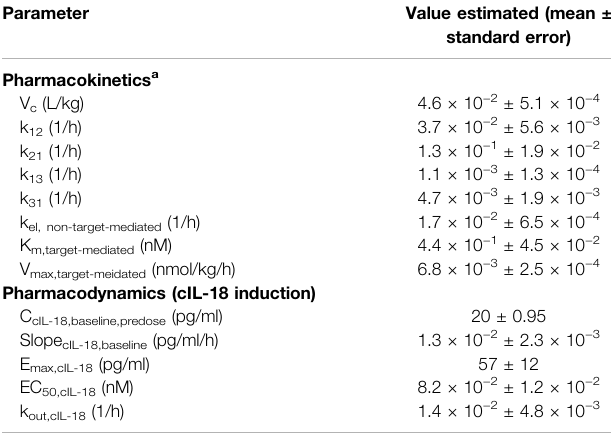
TABLE 2 | Pharmacokinetic and pharmacodynamic parameters estimated for hFc-hIL-10 in cynomolgus monkeys after intravenous administration at 0.06- and 0.18-mg/kg doses given once every two weeks for three doses. Parameter